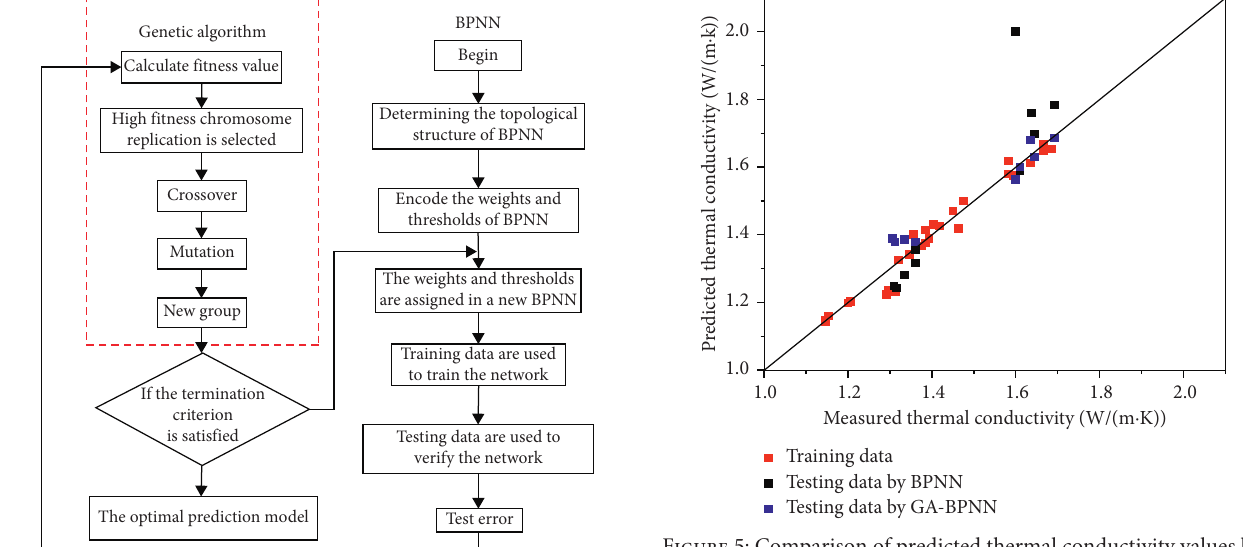
Figure 5: Comparison of predicted thermal conductivity values by measured thermal conductivity.